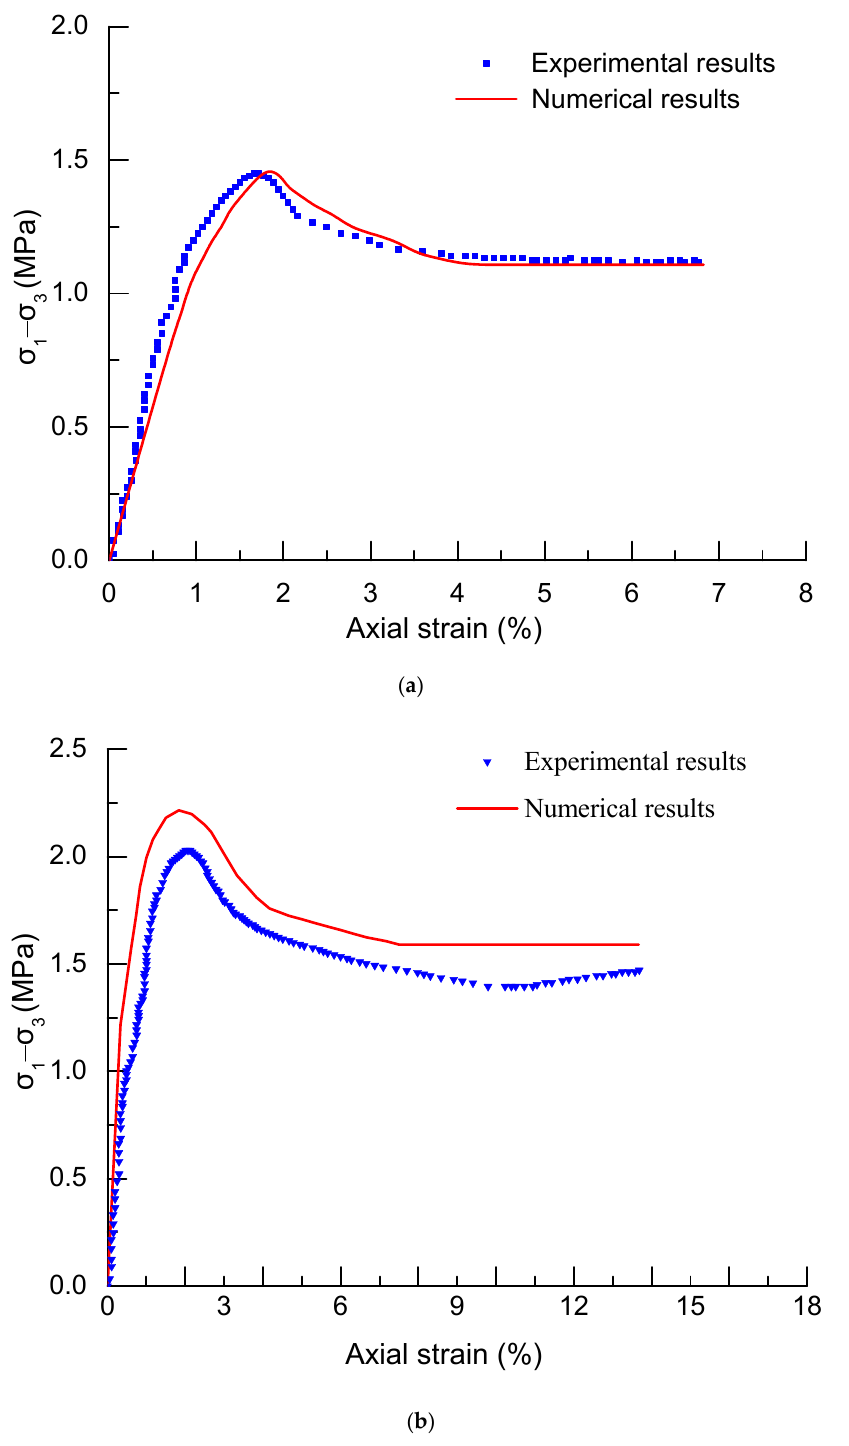
Figure 3. Comparisons between experimental and numerical values. ( a ) Confining pressure is 0.89